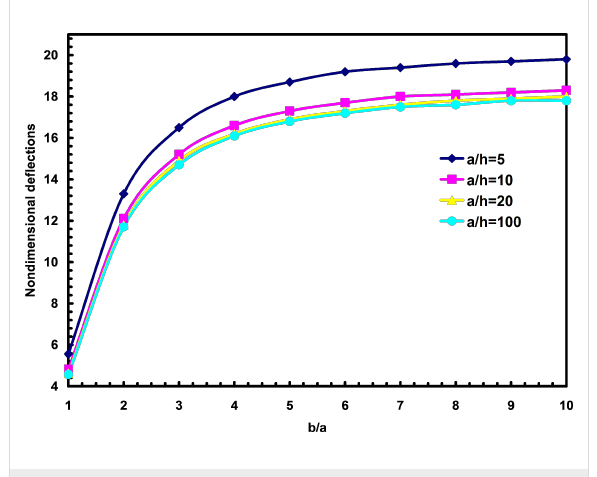
Figure 1: The effects of aspect ratio and length to thickness ratio on the nondimensional deflections.